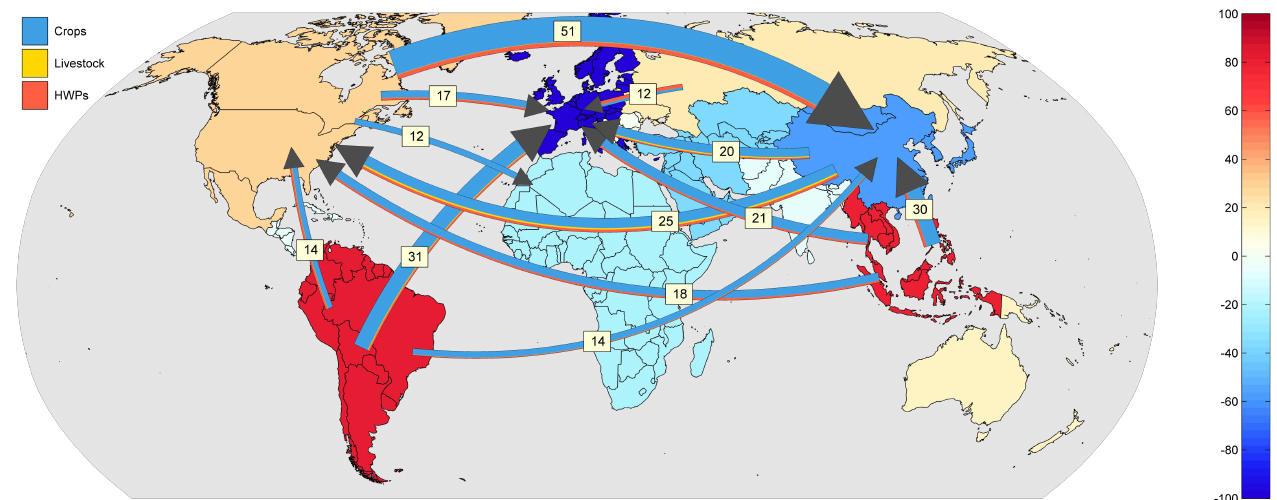
Fig. 10. The top 10 flows for carbon flows in HWPs, crops, and livestock products (2004). The region colours represent the net flows out of each RECCAP region (Table 13). The colours of the arrows refer to the different types of carbon flows. Most flows are dominated by carbon in crops, then HWPs, with the carbon in livestock products much